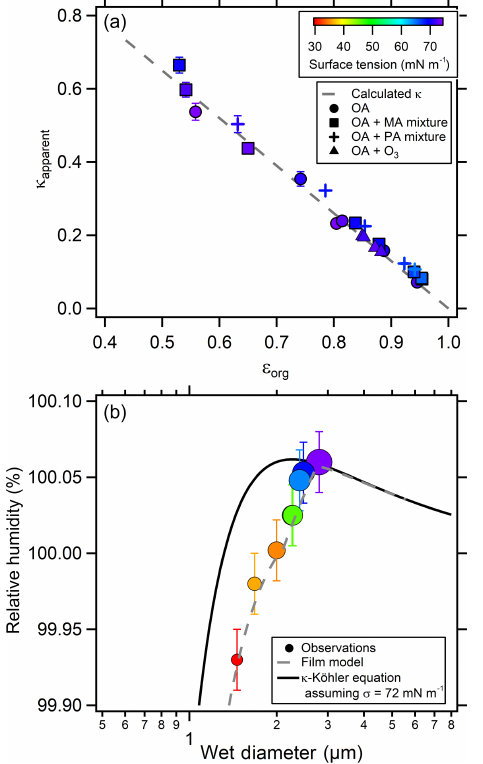
Figure 5. (a) Apparent κ values as a function of ε org as calculated from the critical supersaturation for NaCl particles coated with oleic acid (circles), a mixture of myristic acid and oleic acid (squares), a mixture of palmitic acid and oleic acid (crosses), and oxidized oleic acid (triangles). Also shown is the predicted κ based on vol- ume mixing rules assuming that κ NaCl = 1 . 3 and κ org = 0 . 001, with σ = 72mNm − 1 . Each point is colored by the actual surface tension required to match observations in κ . (b) Relative humidity as a func- tion of measured wet diameter for 150nm (mobility diameter) NaCl particles coated with a fixed amount of oleic acid ( ε org = 0 . 95). Points are colored by upper-limit estimates for surface tension and the size of the points corresponds to the wet diameter. Also shown are values predicted from the compressed film model and κ -Köhler theory assuming σ = 72mNm − 1